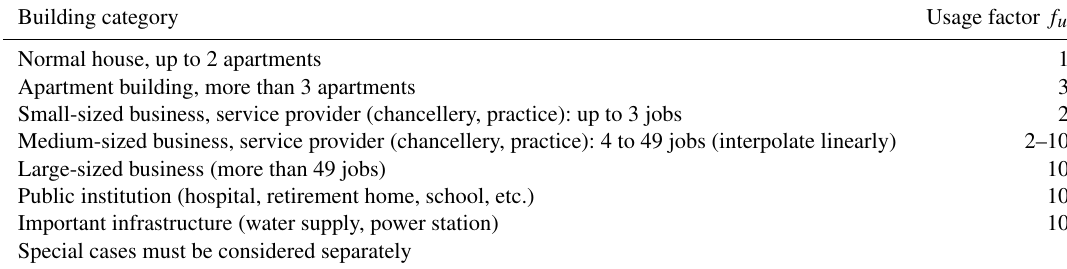
Table 4. Usage factors by building category according to the water management office of Rosenheim. Building category